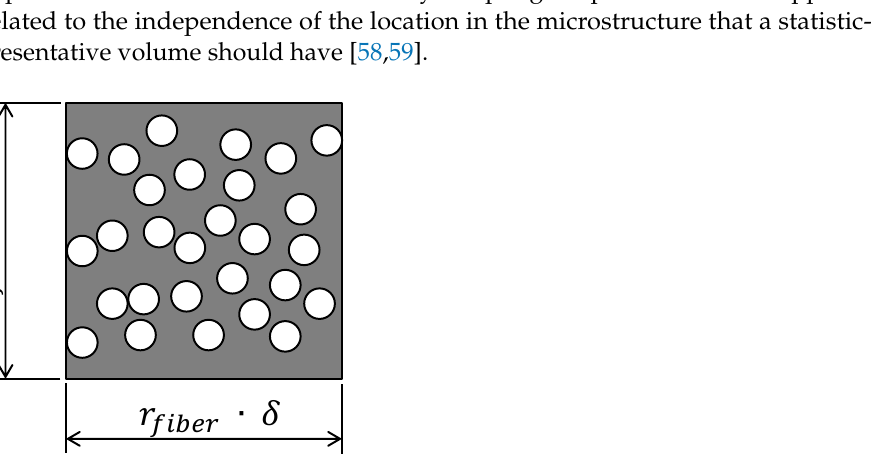
Figure 3. Schematic illustration of a cropped region and its size in function of the parameter δ